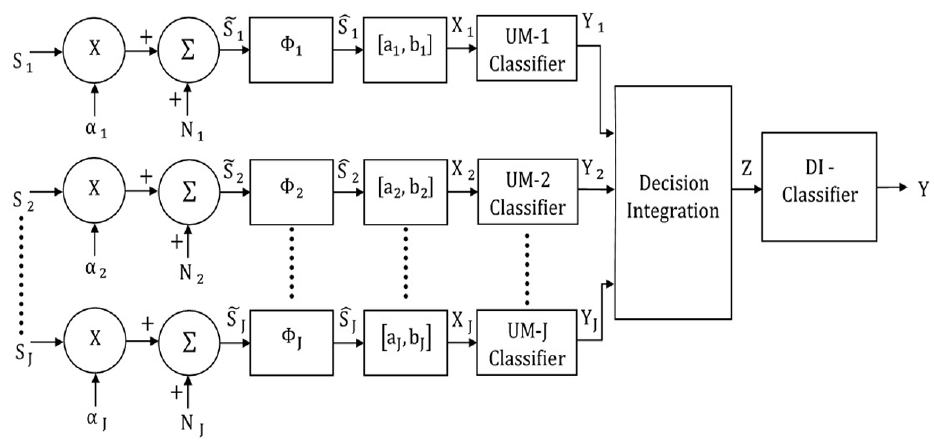
Figure 4. Block diagram of the decision-integrating multimodal classification system.